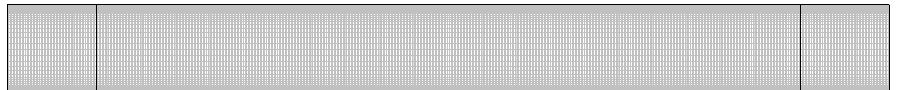
Figure 4. The mesh with rectangular elements used in the numerical computation, where the element size increases exponentially from the wall to the center of the channel. This mesh is fine enough to ensure the EDL is discretized by 10 elements in the scale of 10